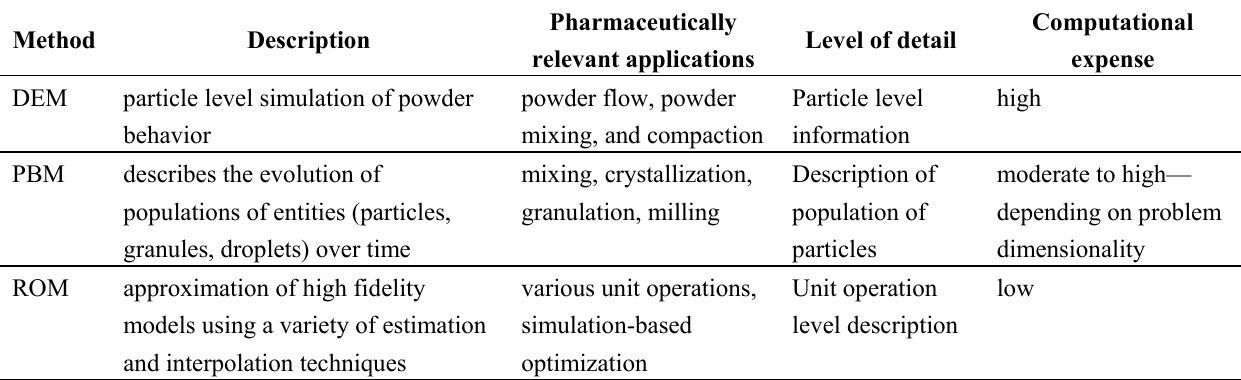
Table 2. Comparison of modeling techniques discussed in section 3 of the current work.